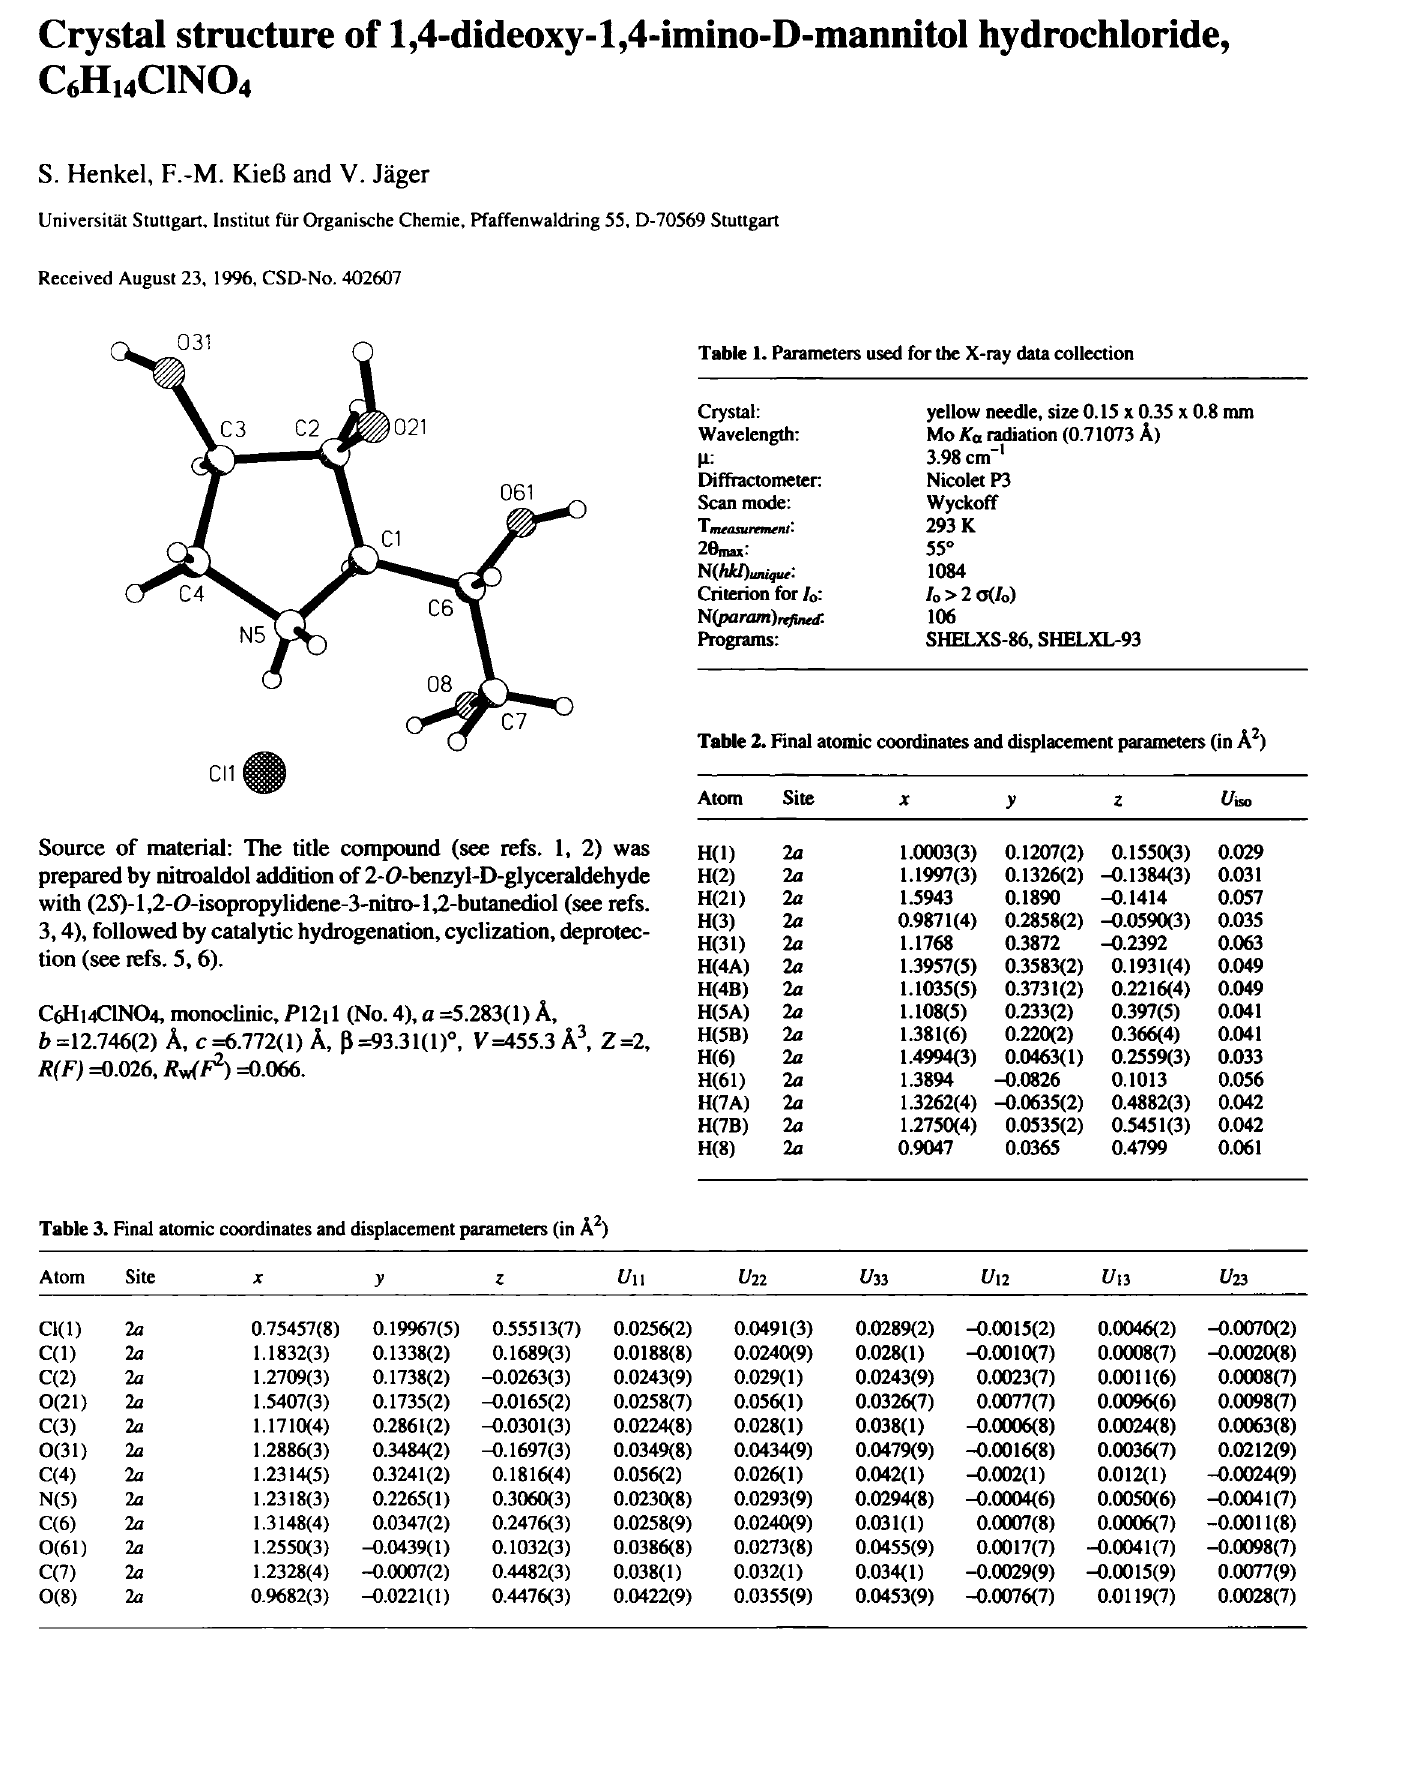
Table 1. Parameters used for the X-ray data collection